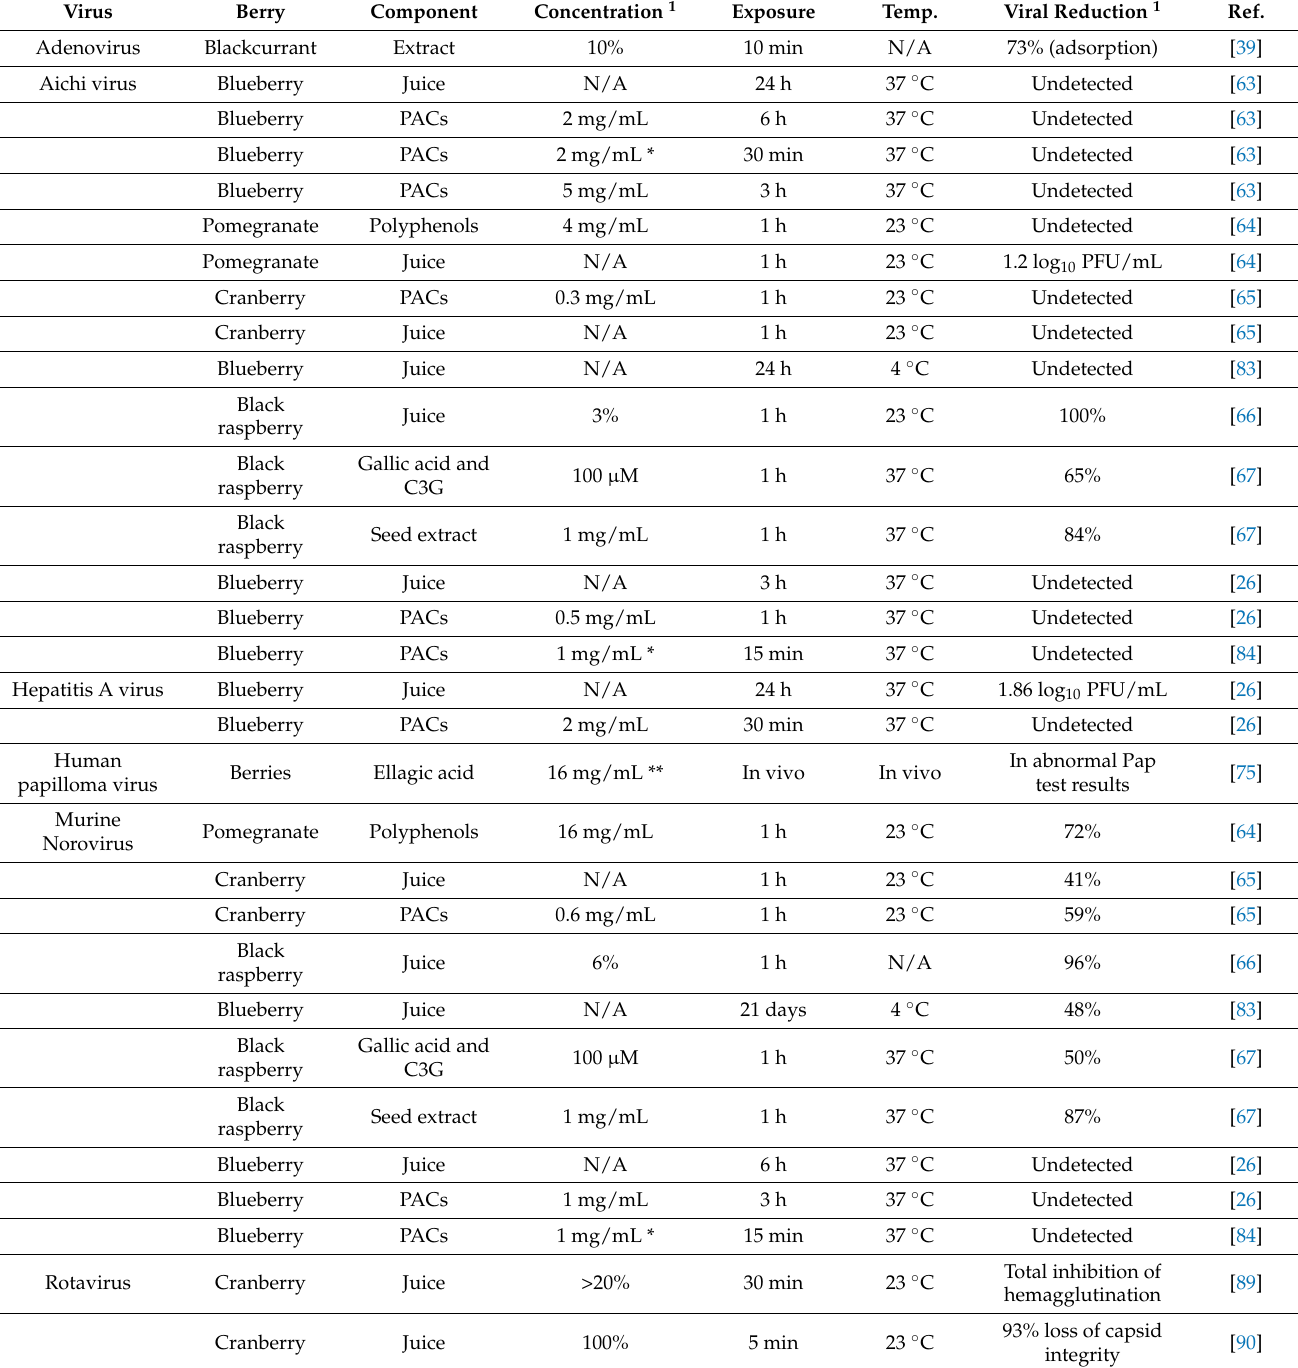
Table 2. Summary of reported antiviral effects of berries or constituents thereof on non-enveloped viruses (or “naked”